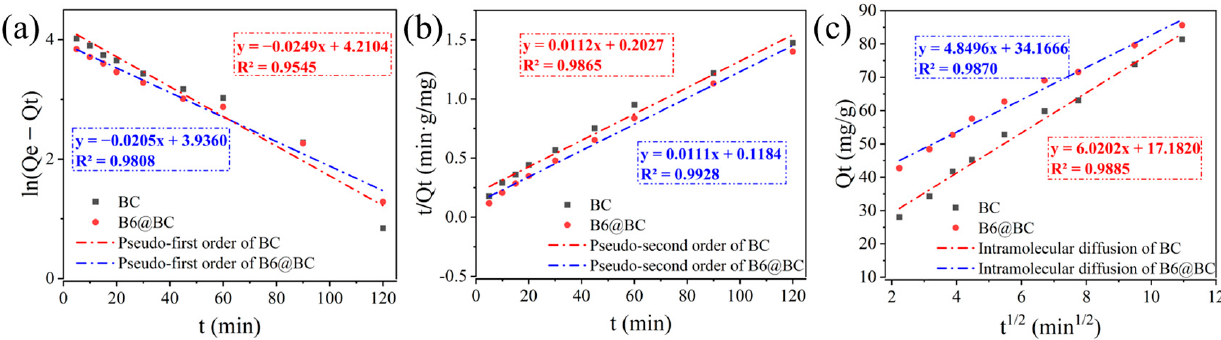
Figure 7. Adsorption kinetic modelling including ( a ) pseudo-first order, ( b ) pseudo-second order, and ( c ) intramolecular diffusion of OTC on BC and